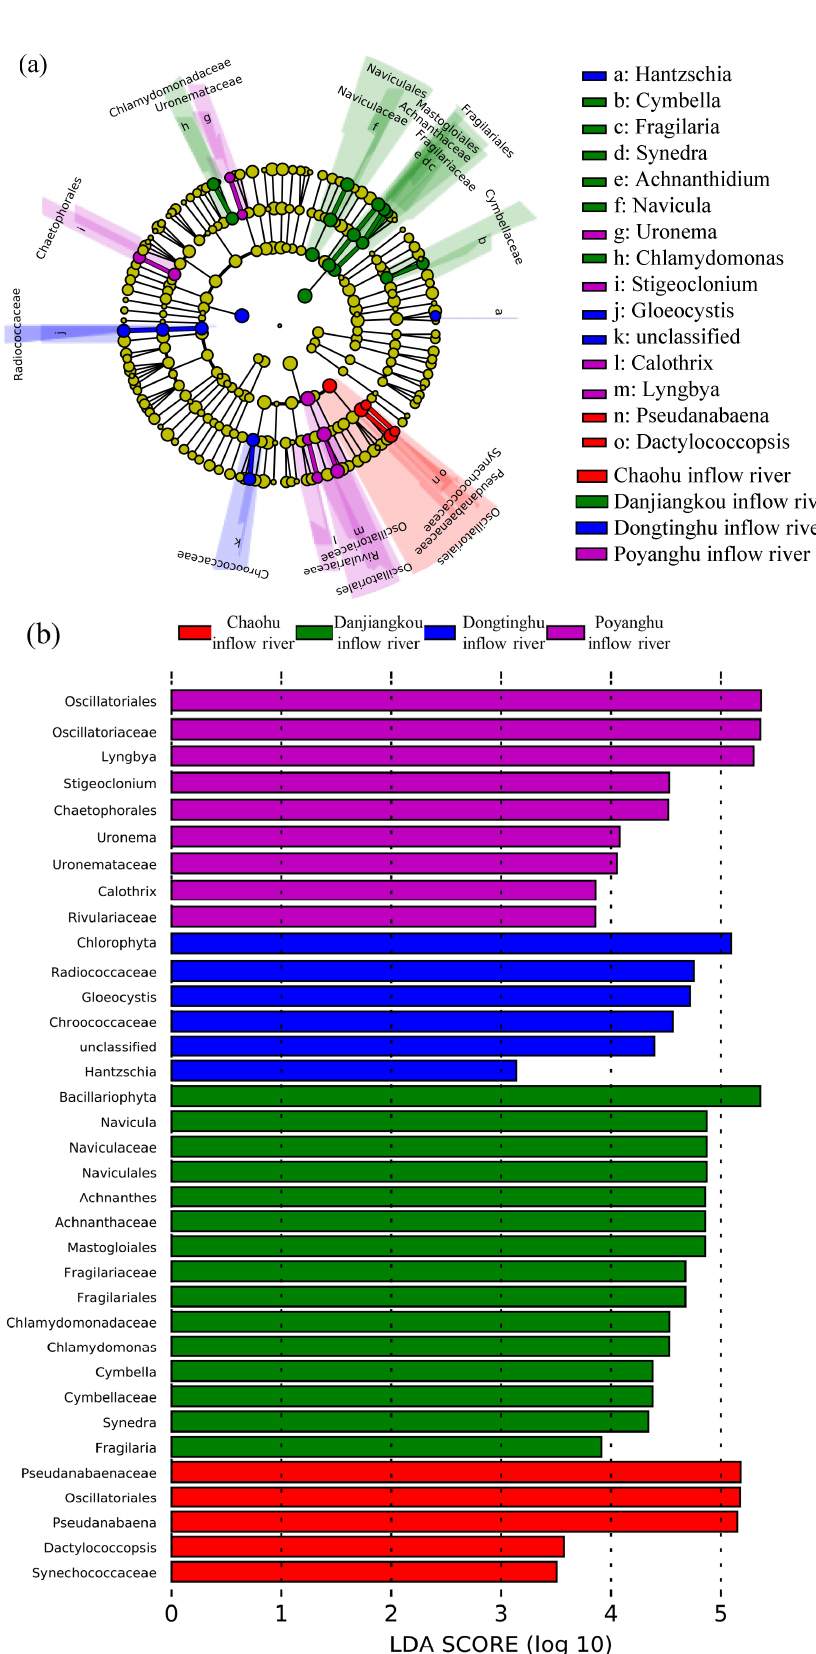
Figure 3. Comparison of periphytic algae variations based on LEfSe analysis. ( a ) Cladogram for taxonomic representation of significantly differences among groups. ( b ) Histogram of the LDA scores for differentially abundant features among